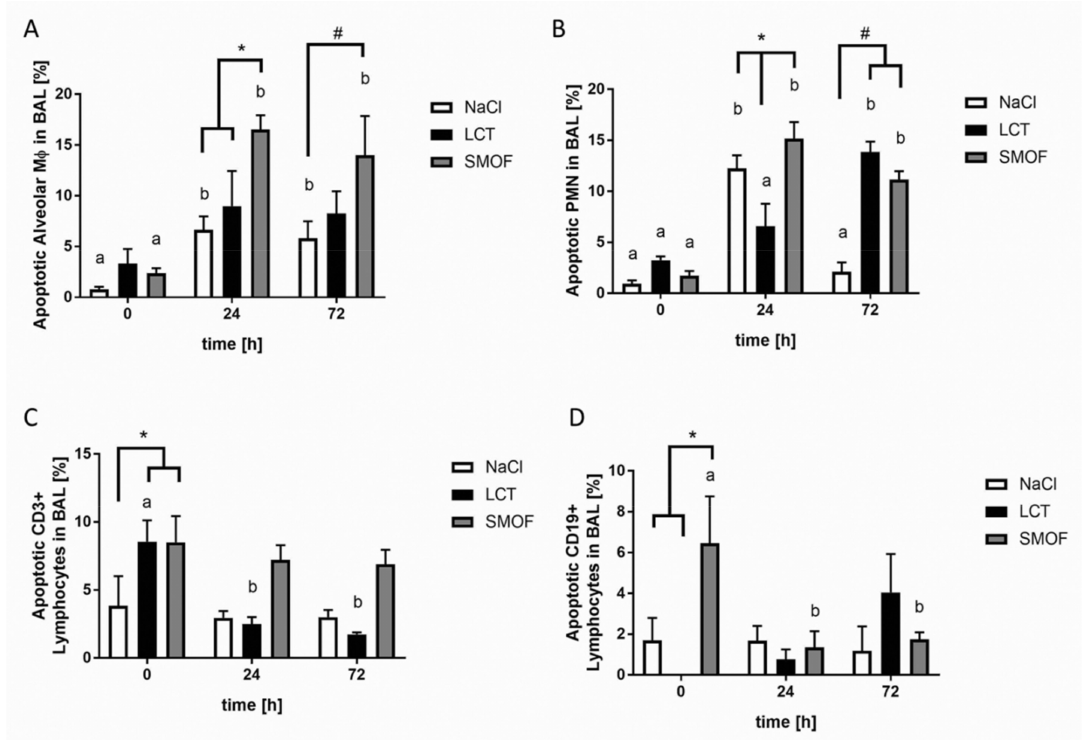
Figure 3. Assessment of alveolar cell apoptosis in LPS-induced acute respiratory distress syndrome. ( A ): Mice receiving SMOF displayed significantly increased apoptotic alveolar M φ -type cells